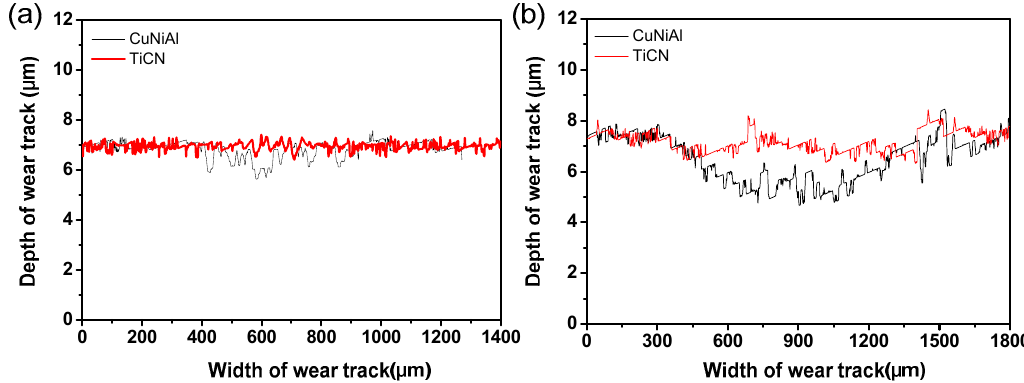
Figure 10. 2D profile of the worn surfaces: ( a ) in oil; and ( b ) in artificial seawater ( P = 106 N).